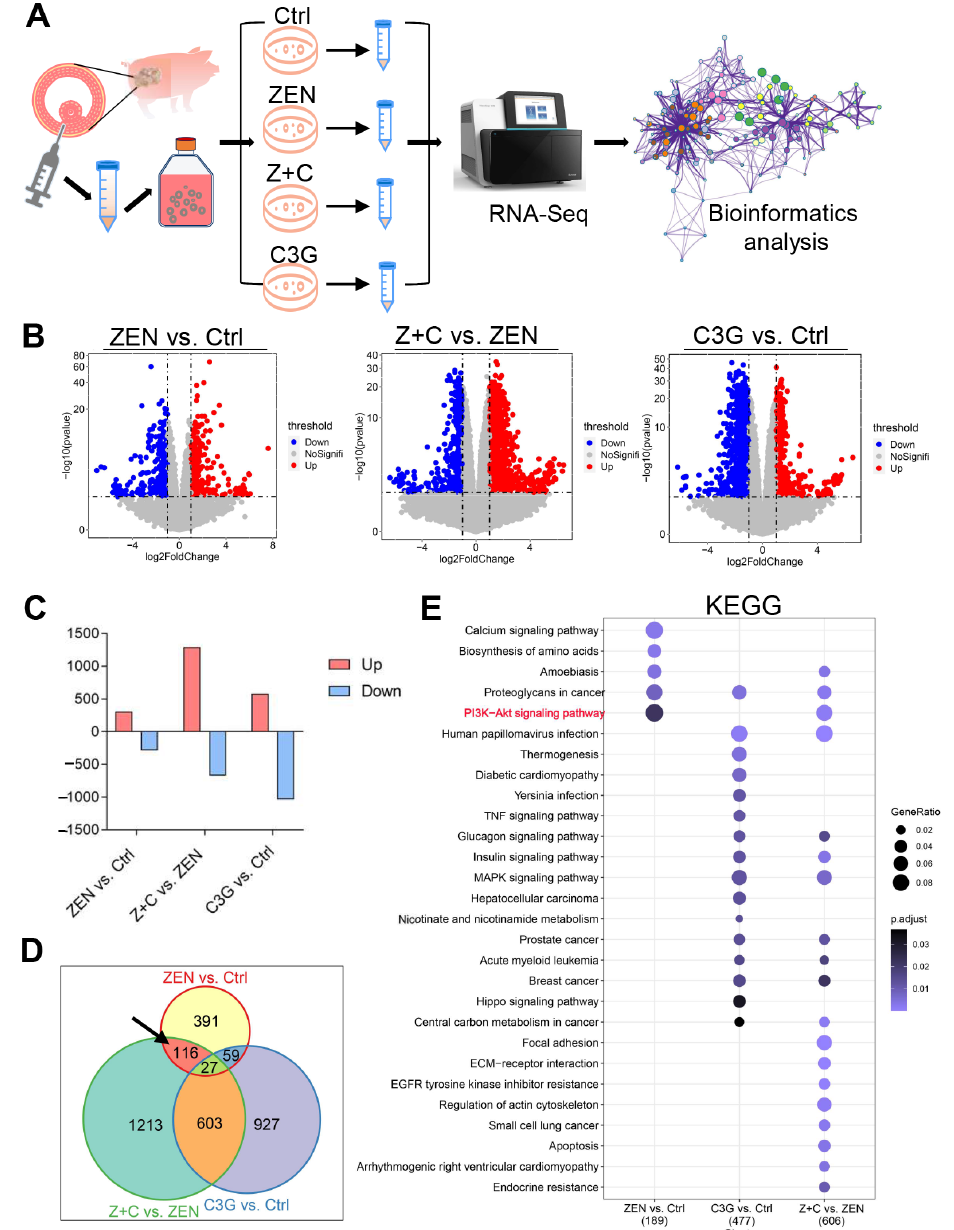
Figure 3. Expression profile and functional analysis of DEGs. ( A ) Experimental scheme of pGCs culture model for RNA-seq in vitro. ( B ) The volcano plot shows the distribution of DEGs between the 3 groups, ZEN vs. Ctrl, Z+C vs. ZEN, and C3G vs. Ctrl. ( C ) The column chart is the number of statistical DEGs in the 3 combinations. ( D ) The Venn diagrams show DEGs in the intersections between DEGs in the 3 combinations; the black arrow points to the genes of interest. ( E ) KEGG analysis of the DEGs.